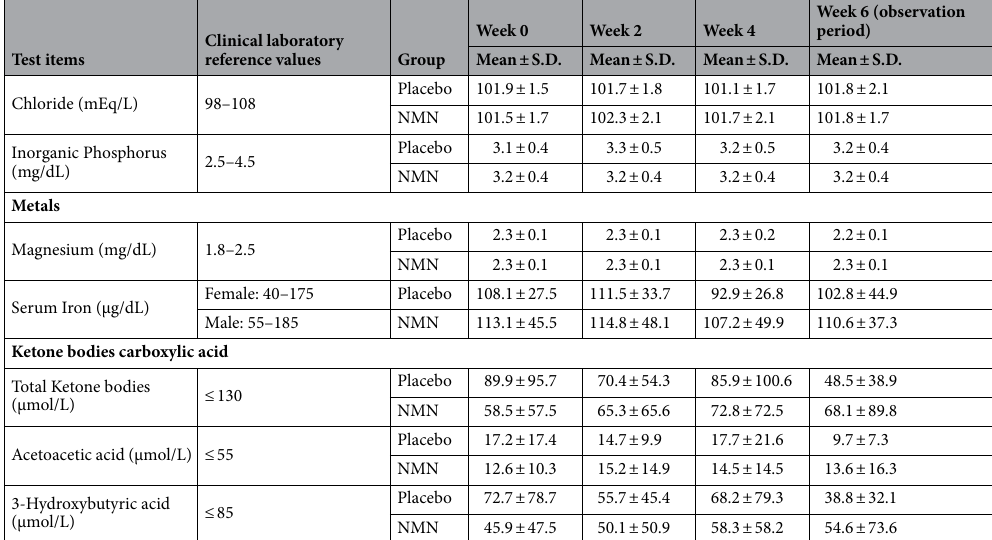
Table 5. Clinical biochemical tests performed during the oral administration period. AST aspartate aminotransferase, GOT glutamate oxaloacetate transaminase, ALT alanine aminotransferase, GPT glutamic pyruvic transaminase, ALP alkaline phosphatase, γ-GT gamma-glutamyltransferase, LD (LDH) lactate dehydrogenase, HDL high-density lipoprotein, LDL low-density lipoprotein. The number of participants in the placebo group was n = 15, while the NMN group comprised n = 16. Statistical significance was determined by two-way analysis of variance and Dunnett’s post-hoc test (two-tailed test) was used to compare the initial value measured at week 0 with all subsequent measurements. Between-group difference comparisons were made using a paired t-test or Welch’s t-test (only AST and ALT, γ-GT, arteriosclerosis index, blood glucose, urea nitrogen, serum iron, total ketone bodies, acetoacetic acid, 3-hydroxybutyric acid). Statistically significant within-group differences were defined as * p < 0.05 versus Week 0. Statistically significant between-group